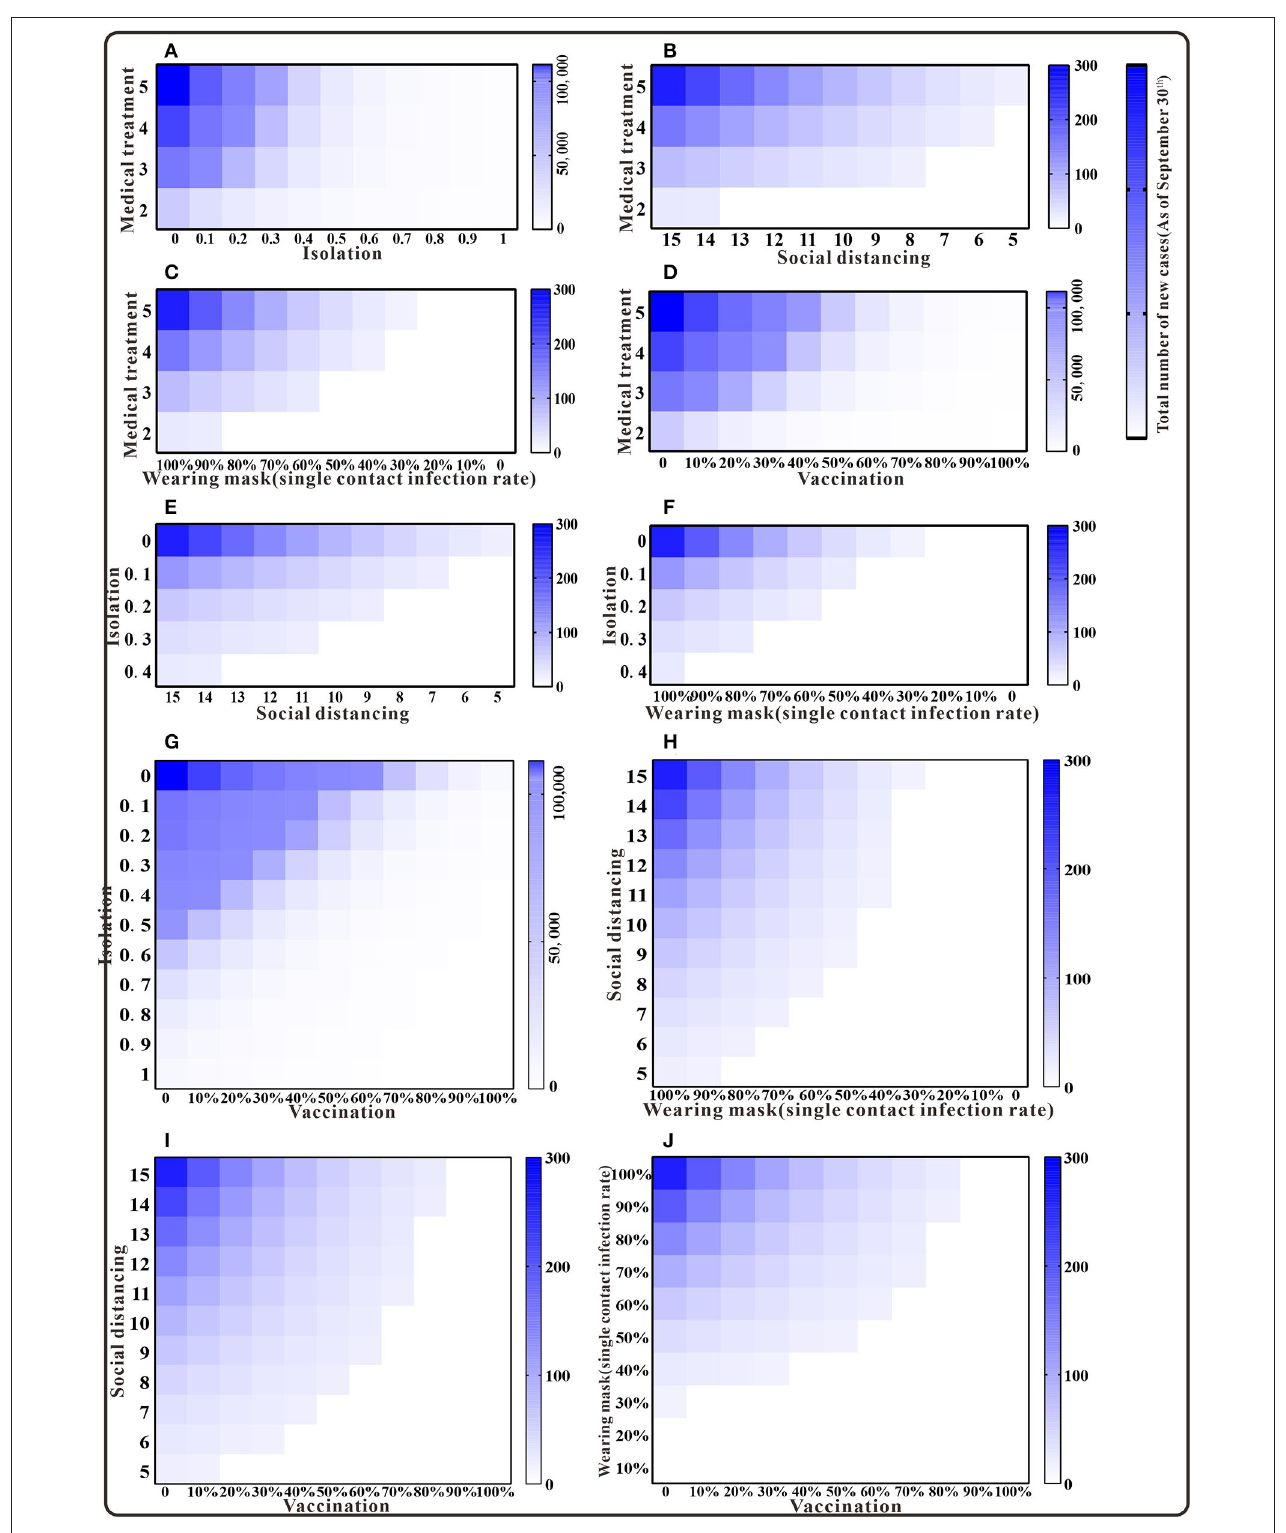
FIGURE 5 | The simulation results of a mix of two interventions in Xiamen City, China, 2021. (A) Medical treatment and isolation; (B) medical treatment and social distancing; (C) medical treatment and wearing mask; (D) medical treatment and vaccination; (E) isolation and social distancing; (F) isolation and wearing mask; (G) isolation and vaccination; (H) social distancing and wearing mask; (I) social distancing and vaccination; and (J) wearing mask and vaccination.